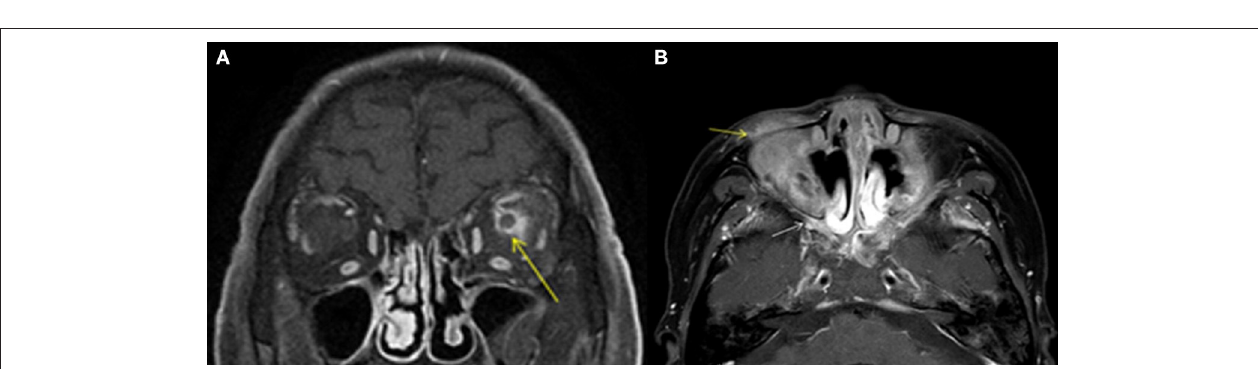
FIGURE 3 | MRI findings of OPN patients with IgG-4 RD. (A) Coronal T2-weighted MRI showing swelling and high signal of the bilateral optic nerve sheath (arrow). (B) Coronal contrast enhanced T1-weighted MRI showing bilateral infraorbital nerve enlargement (arrow).